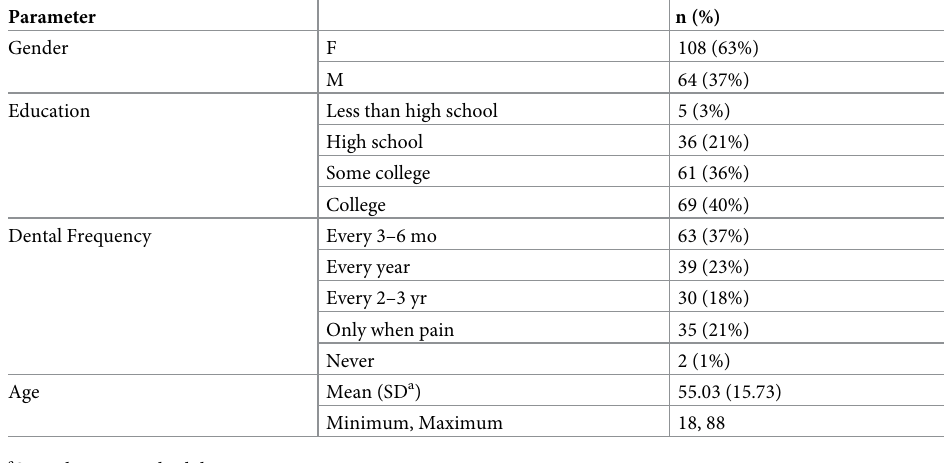
Table 1. Sample descriptive